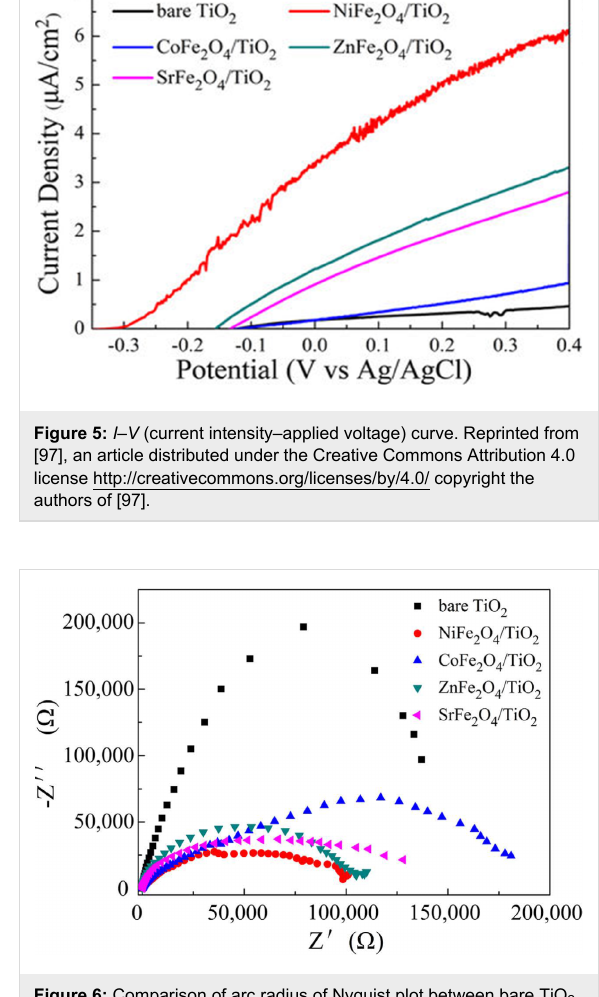
Figure 6: Comparison of arc radius of Nyquist plot between bare TiO 2 and modified TiO 2 (MFe 2 O 4 / TiO 2 ) samples (M = Ni 2+ , Co 2+ , Zn 2+ , Sr 2+ ). Reprinted from [97], an article distributed under the Creative Commons Attribution 4.0 license,